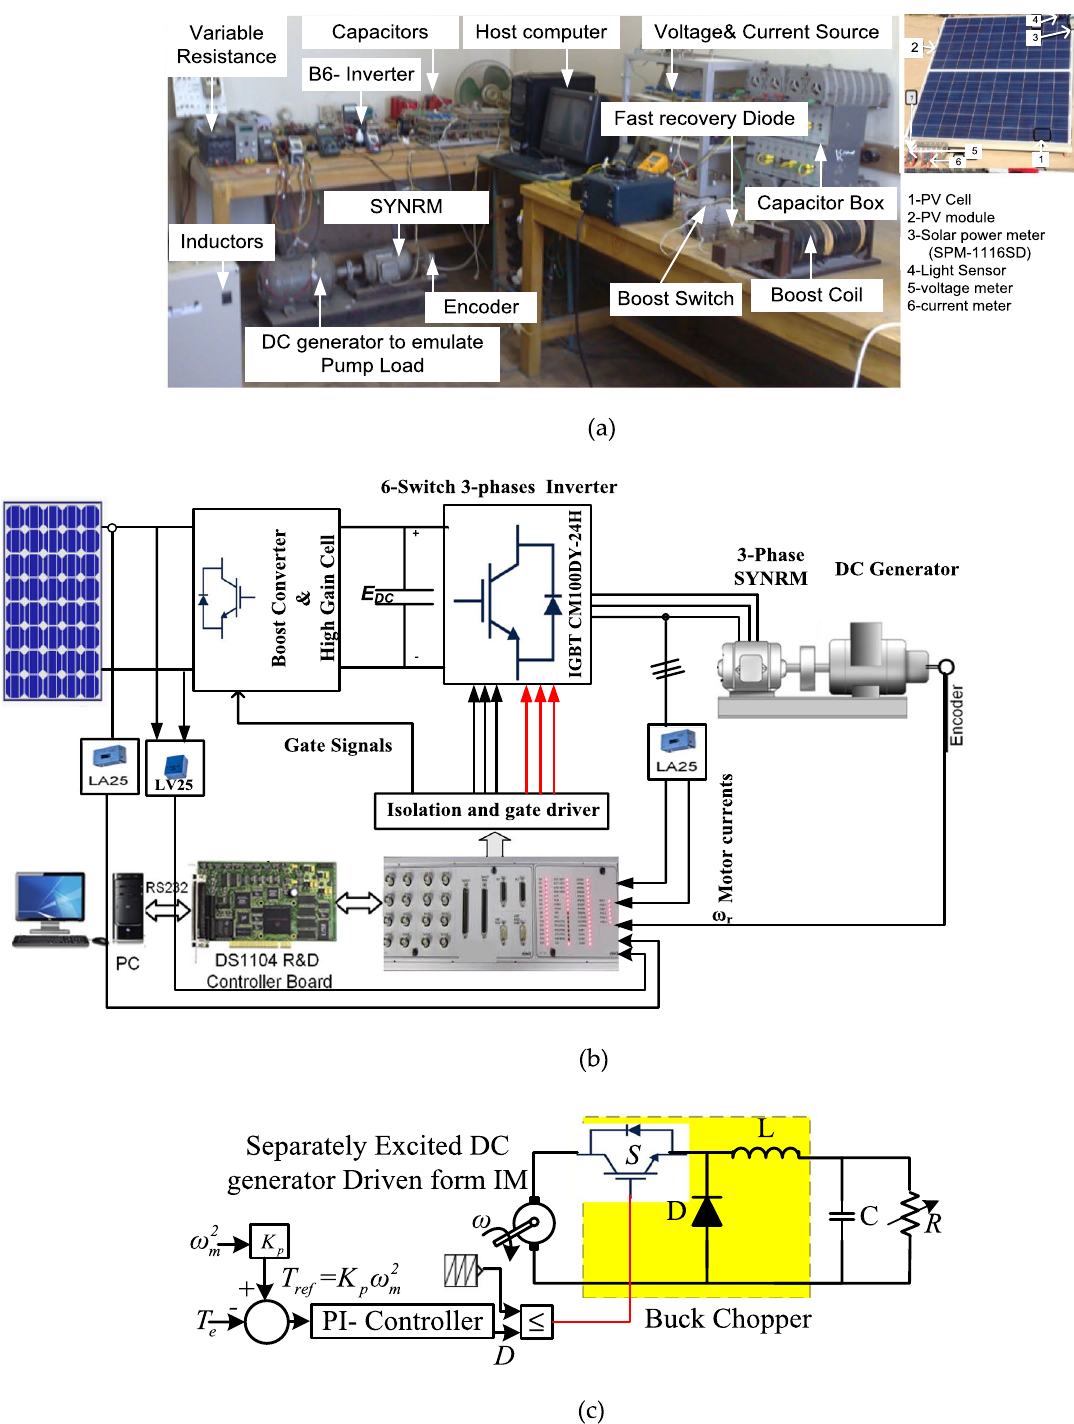
Figure 8. Setup of the laboratory ( a ) wiring diagram, ( b ) implemented image ( c ) load simulation for centrifugal